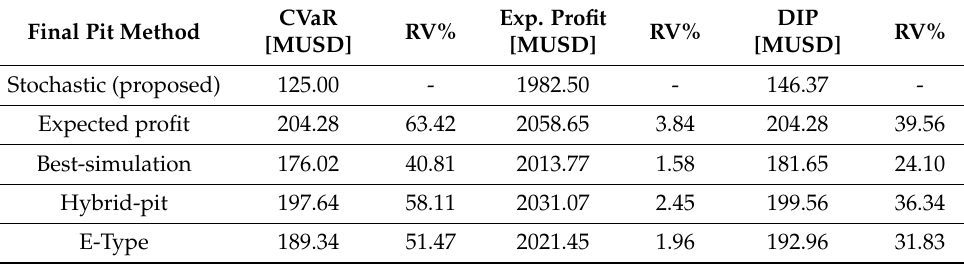
Table 2. A comparison among several final pits alternatives in terms of expected profit and risk